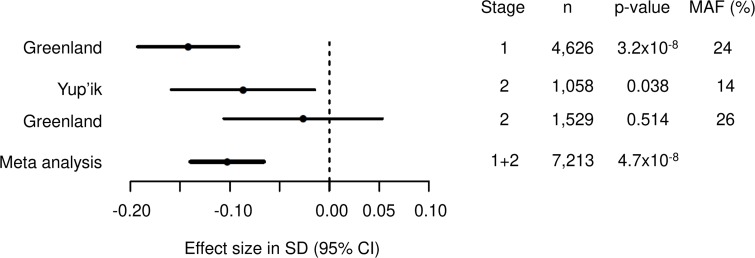
Forest plot of association between rs4936356 and BMI.Fixed-effect meta-analysis of 7,213 individuals from three different Arctic study populations. Heterogeneity between the populations was assessed with Cochrane’s Q (p = 0.05).